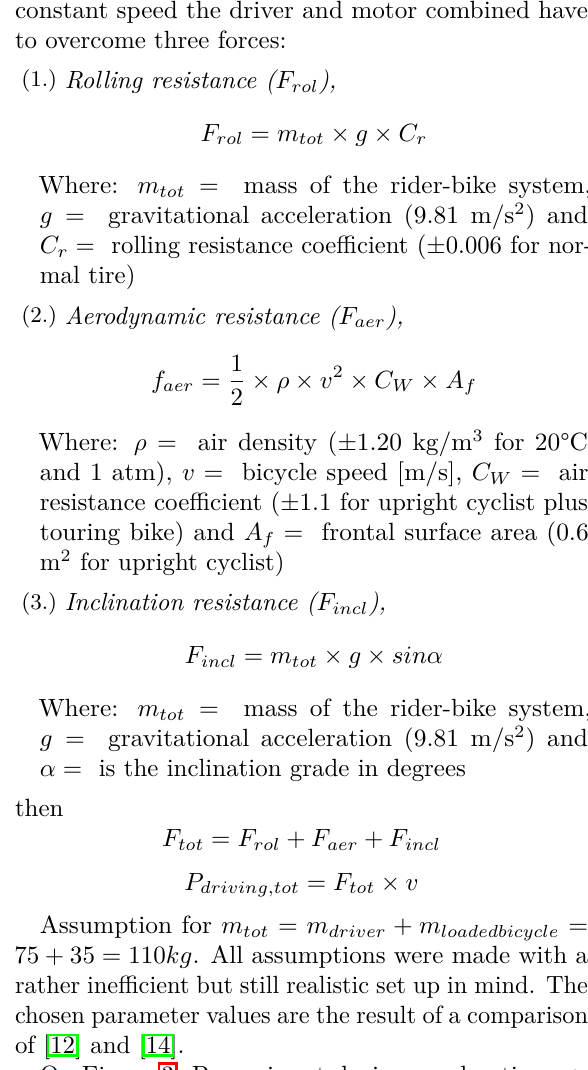
On Figure 3: Power input during acceleration => from 0 to 25km/h in 3 seconds => F = m × ( v 2 − v 1) /t .